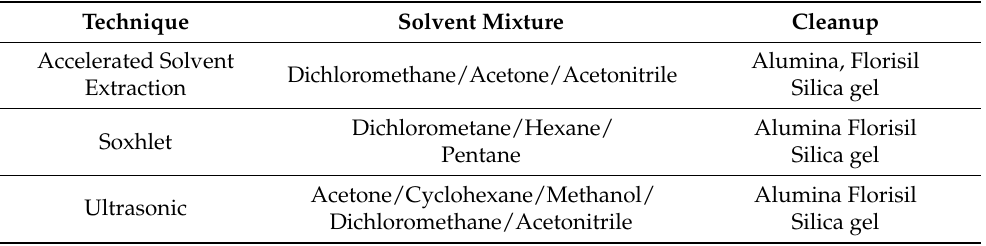
Table 1. Different analytical procedures (extraction, cleanup and analysis) for